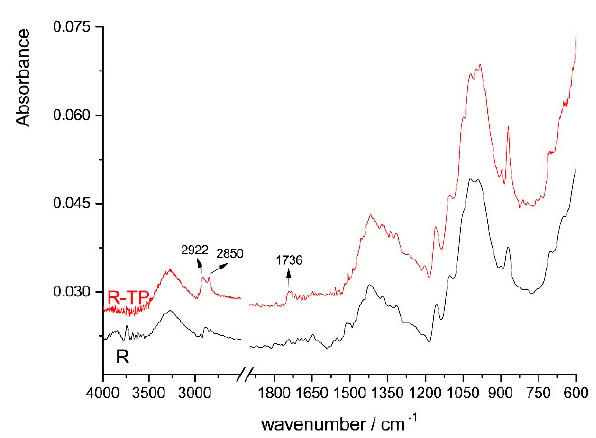
Figure 10. FTIR spectra of recycled paper (R) and thermochromic print on recycled paper (R-TP).